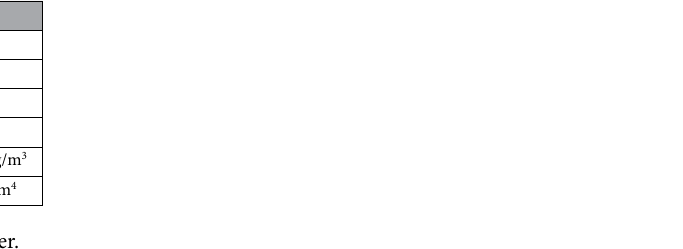
Table 3. Parameters of rigid cylinder.